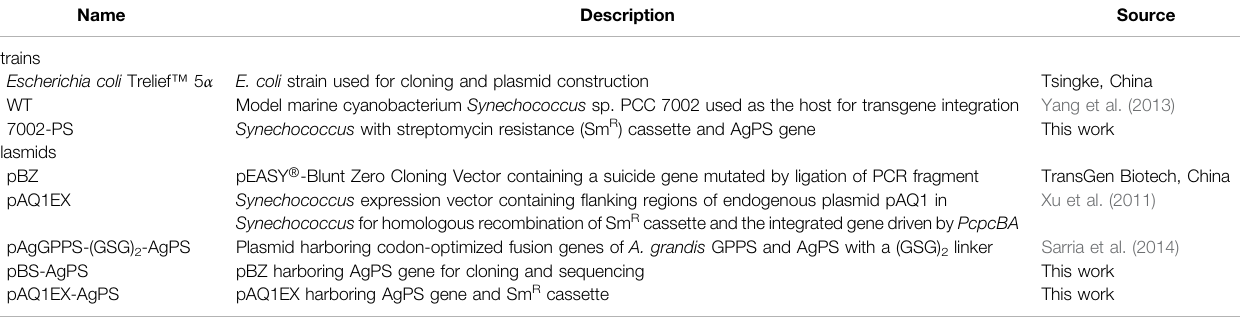
TABLE 1 | Strains and plasmids used in this study.